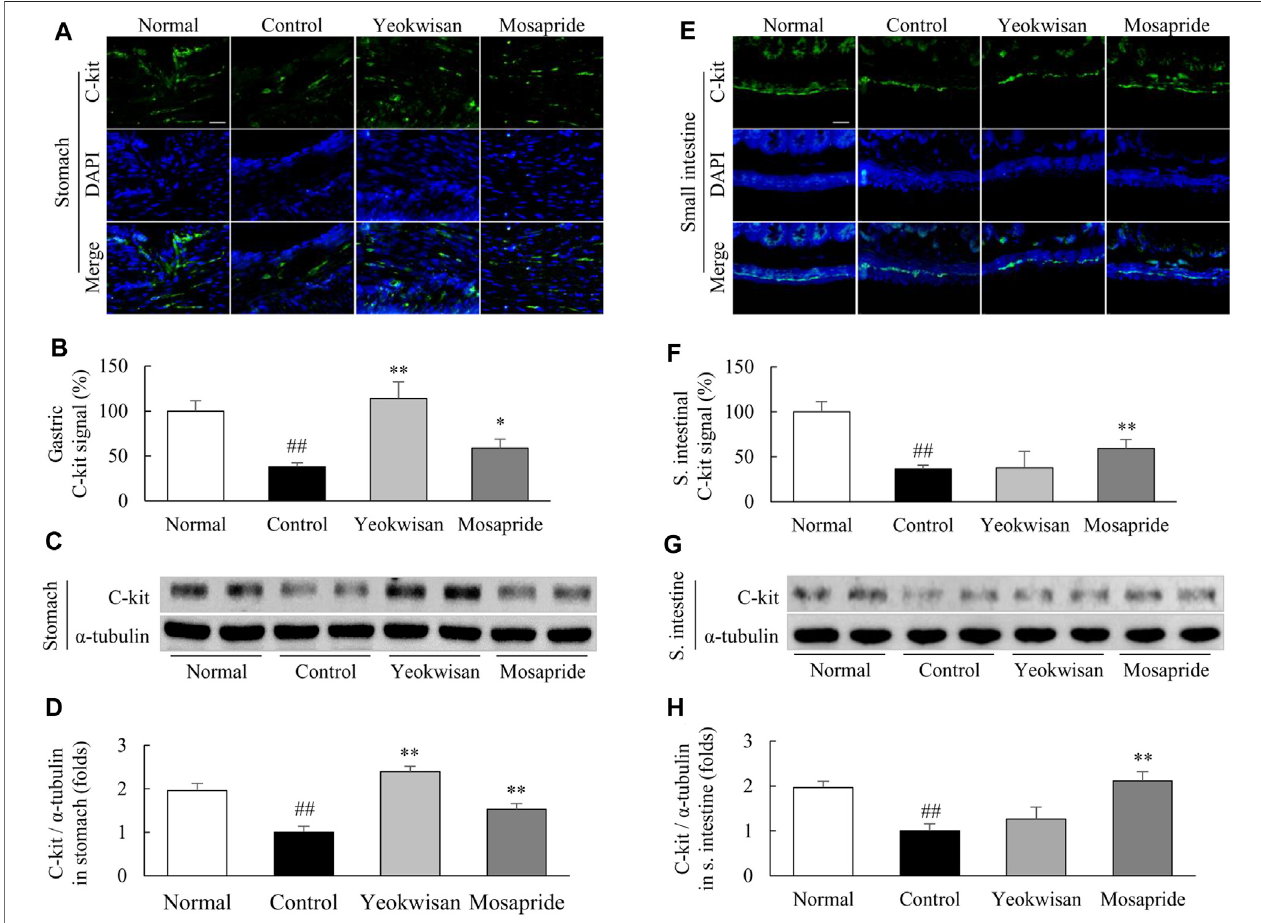
FIGURE4 | Effectsof Yeokwisan on C-kit protein expression in the stomach and small intestine tissues. C-kitprotein expression wassemiquantitativelymeasured using immuno fl uorescence in the stomach (A,B) and small intestine (E,F) and semiquantitatively measured using western blotting in the stomach (C,D) and small intestine (G,H) . Immuno fl uorescence was observed under an optical microscope (200 × magni fi cation), and the scale bar indicates 50 μ m. The Yeokwisan group was treated with a dose of 400 mg/kg in these results. The data are presented as the mean ± SEM. ## p < 0.01 compared with the normal group; * p < 0.05, ** p < 0.01 compared with the control